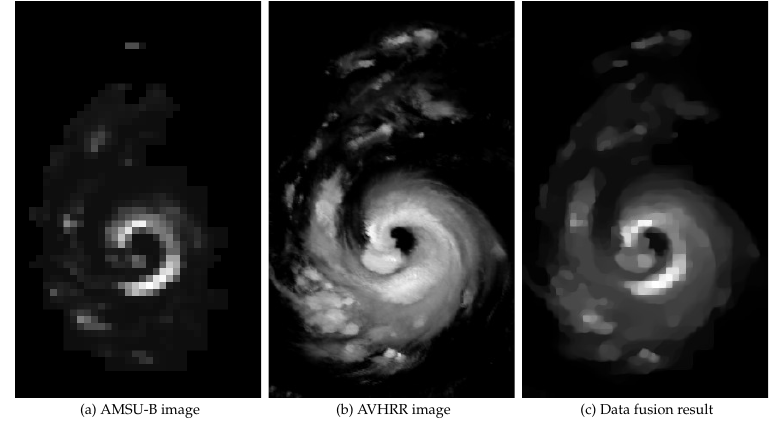
Figure 1. ( a ) AMSU-B image at 15 km resolution, ( b ) AVHRR image at 1.9 km resolution, and ( c ) data Figure 1. (a) AMSU-B image at 15 km resolution, (b) AVHRR image at 1.9 km resolution, and (c) data fusion result at 1.9 km resolution are shown. fusion result at 1.9 km resolution are shown.